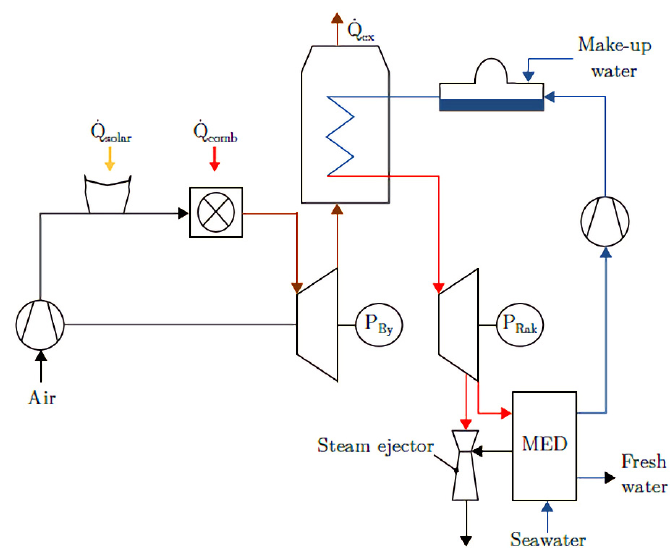
Figure 5. LT-MED unit integrated into the combined cycle of the CRS plant.